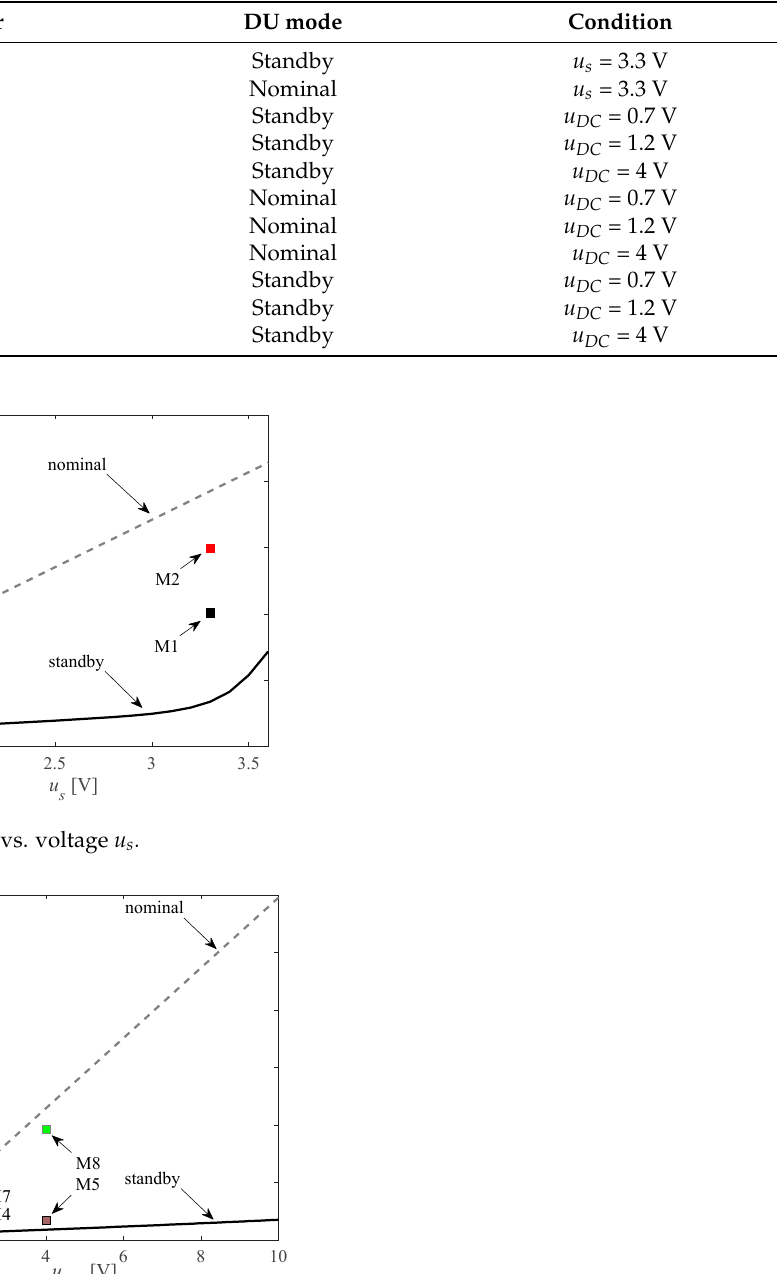
Table 1. Conditions of current-consumption measurements.